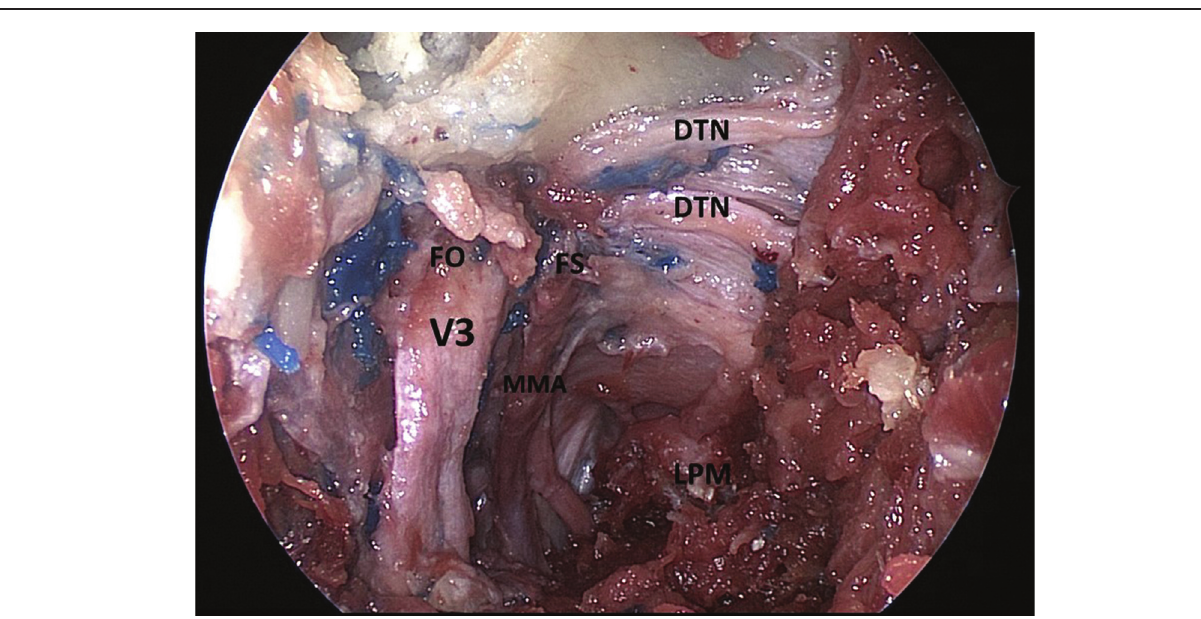
Close view of the left mandibular